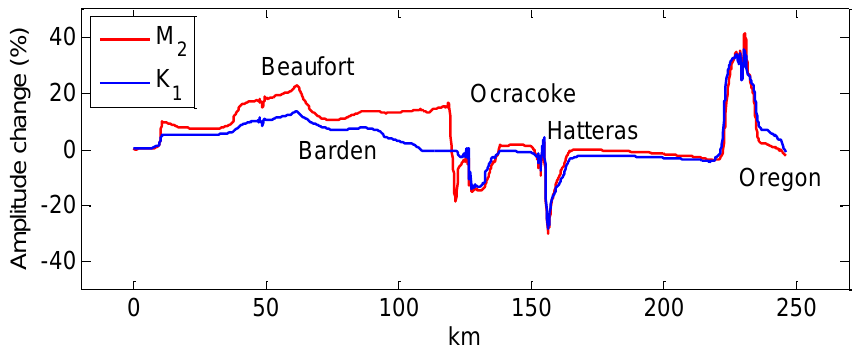
Figure 16. Comparison between the M 2 (red line) and K 1 (blue line) in amplitude change between the new-bathy model and the old-bathy model relative to the old-bathy model along a line (shown in Figure 2b) about 1 km behind the barrier islands.